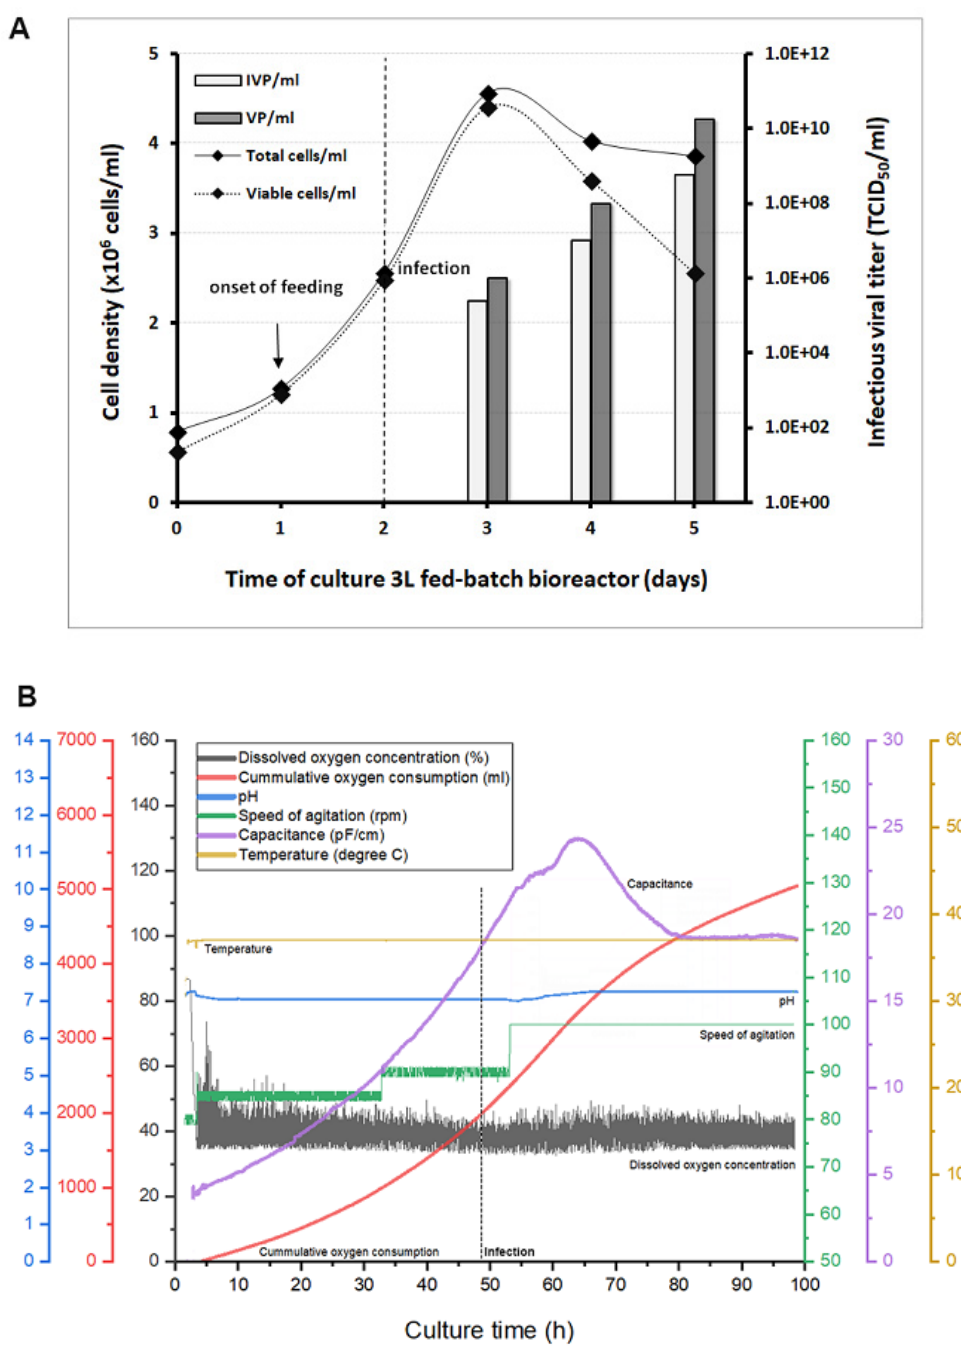
Figure 5. Adenoviral vector production in a 3 L controlled bioreactor operated in fed-batch mode for the production of one adenoviral vector as vaccine candidate: ( A ) Time course of the viable and total cell growth in Xell AG HEK-GM medium in which the feed supplement was initiated at a cell concentration of 1 × 10 6 cells / mL as indicated in the figure. The infection was set at a cell density of 2 × 10 6 cells / mL, and the final cell density during the virus production phase reached 4.56 × 10 6 cells / mL. The cultures were strictly monitored and harvested when the cell viability reached approximately 60–70%. At harvest, the infectious viral particles of the Ad-F-HN-CMV produced reached 5.8 × 10 8 TCID 50 / mL in the